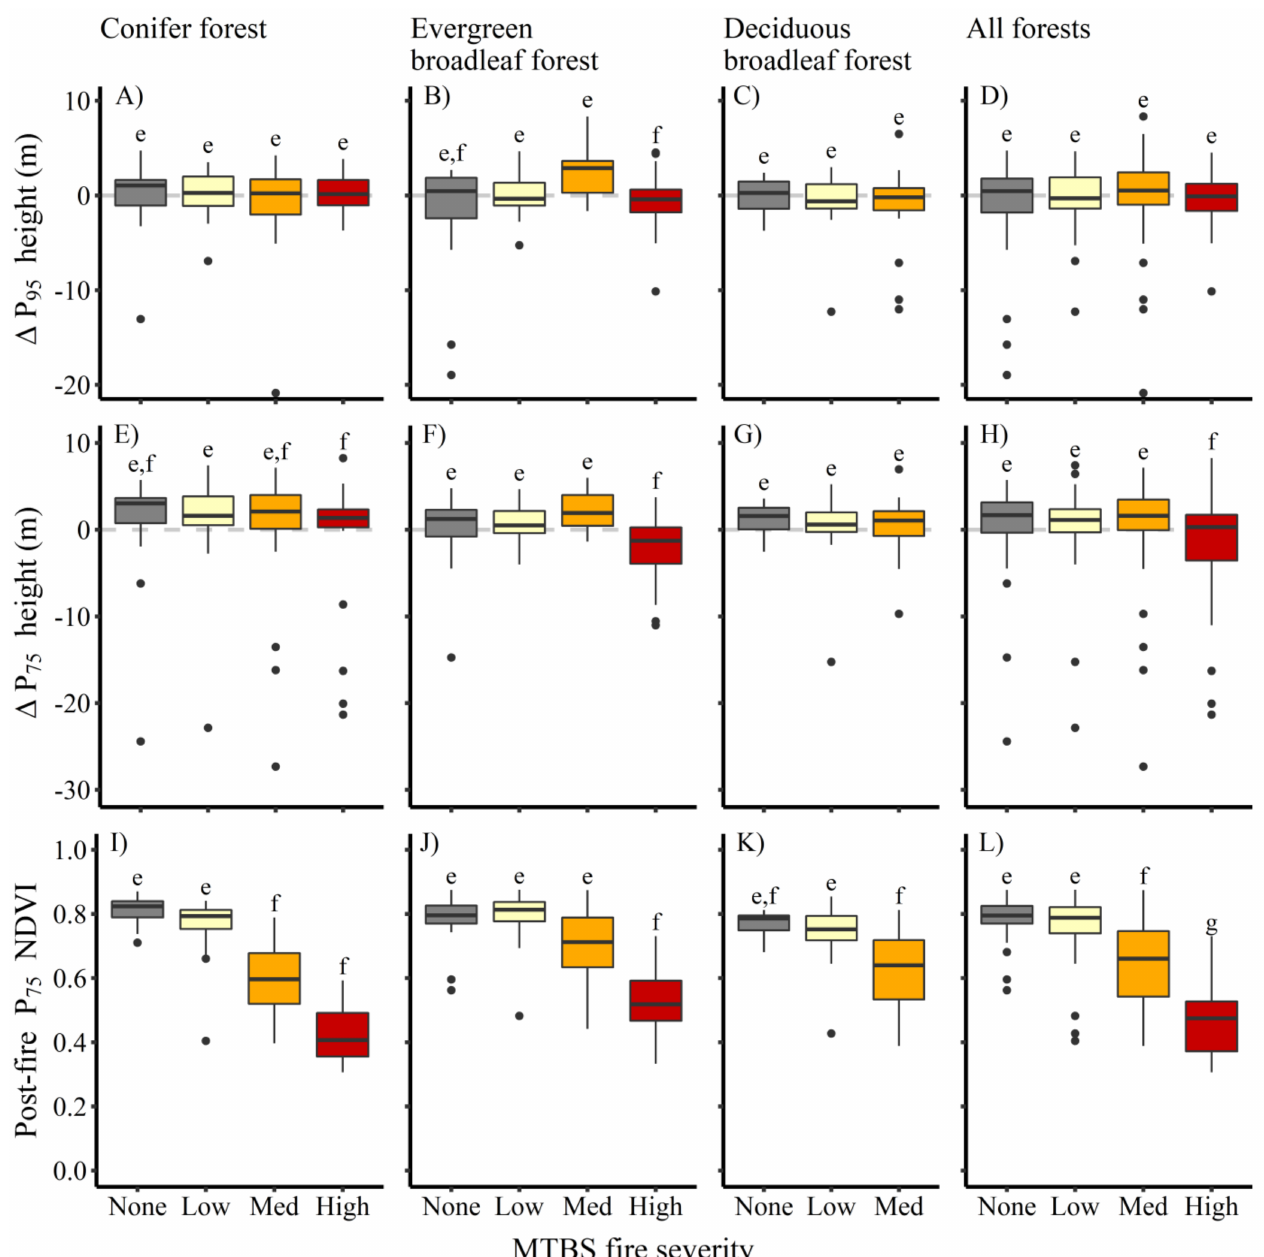
Figure 8. The impact of the 2017 Tubbs Fire on 95th percentile (P 95 ) and 75th percentile heights (P 75 ) and P 75 mean NDVI by MTBS fire severity in forest types. Lower case letters represent statistically similar groups at the 95% confidence level. Change in canopy height metrics calculated as pre-fire ALS percentile height minus post-fire UAS-SfM percentile